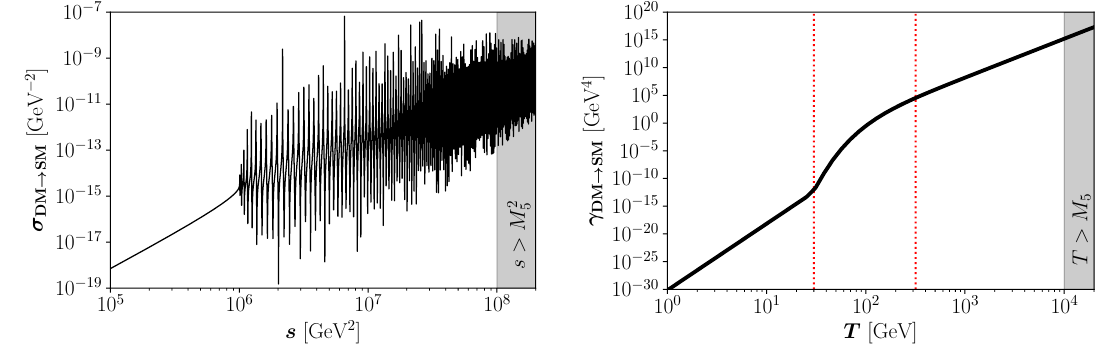
Figure 1 . Black solid lines represent the DM annihilation cross-section (left panel) and interaction rate density (right panel) for k = 10 3 GeV, M 5 = 10 4 GeV and m DM = 1 MeV. Red-dotted vertical lines in the right panel depict the different regimes in eq. (3.7). The gray-shaded regions on the right of both panels are beyond the EFT